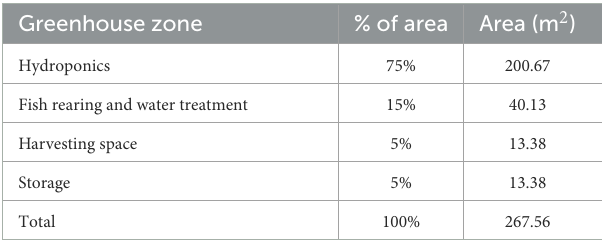
TABLE 1 Area allotment for greenhouse